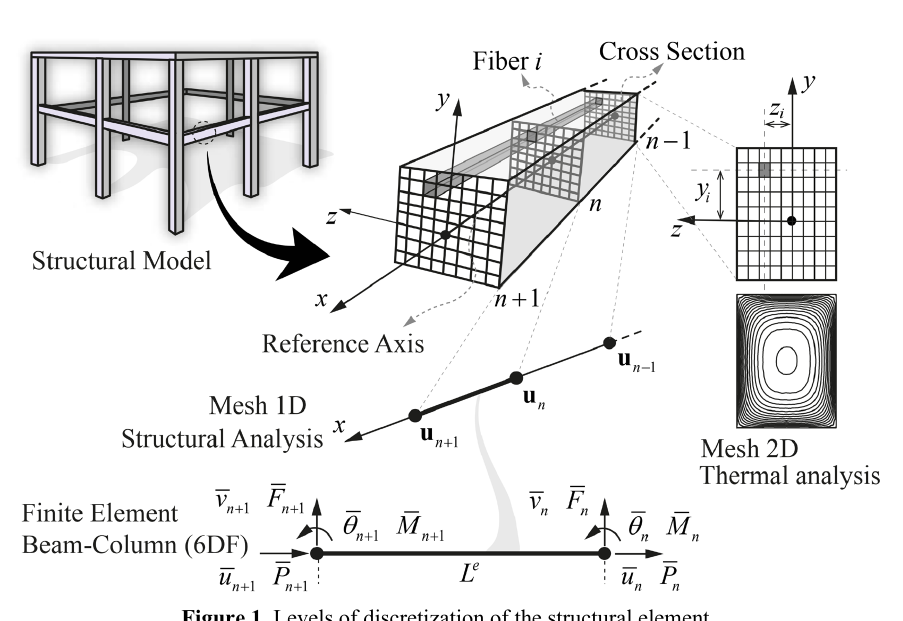
Figure 1. Levels of discretization of the structural